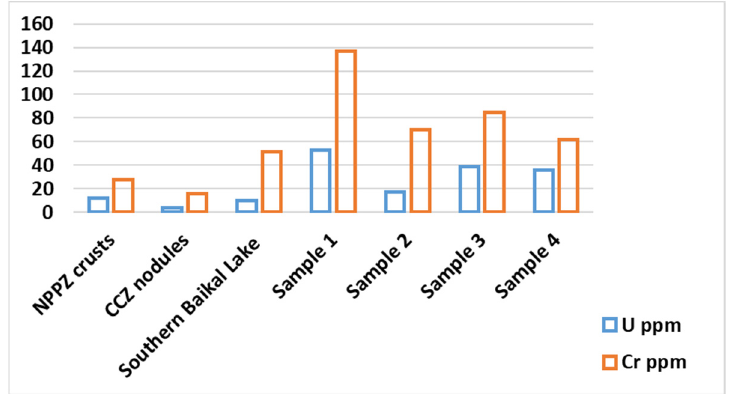
Figure 3. U and Cr concentrations in Fe-Mn nodules from the slope of Bolshoy Ushkany Island and the Southern basin of Lake Baikal (our data), cobalt-rich crusts from North Pacific Prime Zone (NPPZ) and nodules of the Clarion–Clipperton Zone in the Pacific Ocean (CCZ) [5,73].